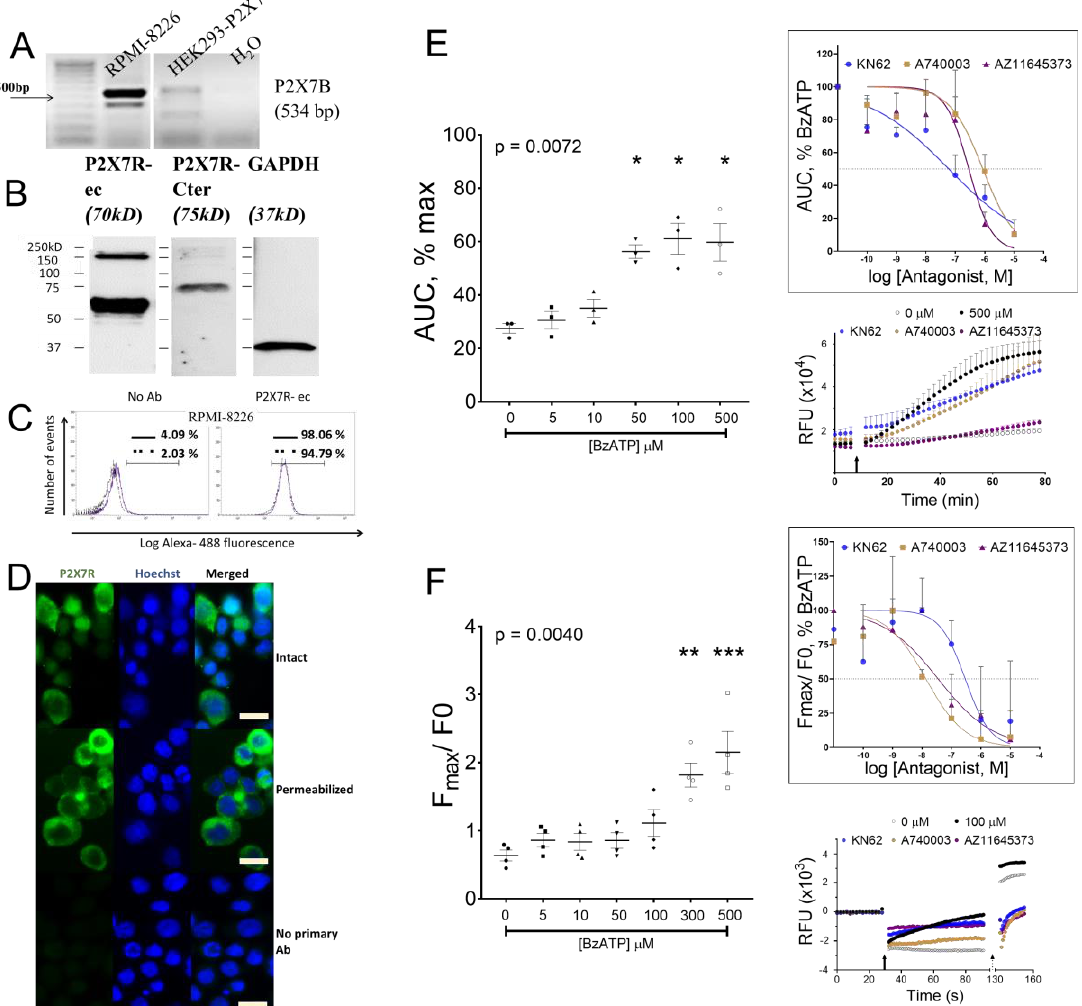
Figure 2. Characterization of P2X7 receptor in RPMI-8226. ( A ) Semi quantitative RT-PCR shows the transcript for truncated variant of P2X7 receptor compared to HEK293 cells stably transfected with P2X7 receptor used a positive control. ( B ) Whole-cell lysates were immunoblotted with antibody P2X7R-Cter (specific to the A isoform), showing a positive but lower intensity band compared to the P2X7R-ec (common to both A and B isoforms); GAPDH (right panel) was the loading control. ( C ) Histograms from flow cytometric analysis of intact (solid line) and permeabilized (dotted line) RPMI-8226 stained with monoclonal antibody P2X7R-ec or negative control (no Ab) with only secondary antibody to show percentage of positive cells (horizontal bar). ( D ) Microscopic images of RPMI-8226 stained with monoclonal antibody P2X7R-ec when intact (top), permeabilized (middle), and with no primary negative control (bottom). Hoescht was used to stain cell nuclei; scale bar 10 µm. ( E ) YO-PRO-1 uptake with increasing doses of BzATP shown as area under the curve (AUC) of maximum (cell lysis), and (inset) with 500 µM BzATP against increasing doses of antagonists (KN62, A740003, or AZ11645373). Injection trace of YO-PRO-1 uptake with BzATP (arrow marking the injection point) in the presence or absence of 1 µM KN62, 1 µM A740003, or 1 µM AZ11645373. Data shows mean ± SEM of three independent experiments ( n ) with six replicate wells per treatment ( n = 2 with 6 replicate wells of each antagonist concentration) and * = p < 0.05, Kruskal–Wallis comparison with multiple corrections of each treatment to 0 µM BzATP. ( F ) Influx of Ca 2+ evoked by increasing doses of BzATP, shown as peak fluorescence (Fmax) as a change from baseline (before stimulus, F0), and (inset) by 100 µM BzATP against increasing doses of antagonists (KN62, A740003, or AZ11645373). Injection trace of relative fluorescence (arrow marking the injection point; ionophore was used for full response shown at dotted arrow) in the presence or absence of 1 µM KN62, 1 µM A740003, or 1 µM AZ11645373. Data shows mean ± SEM of four independent experiments ( n ) with three replicate wells